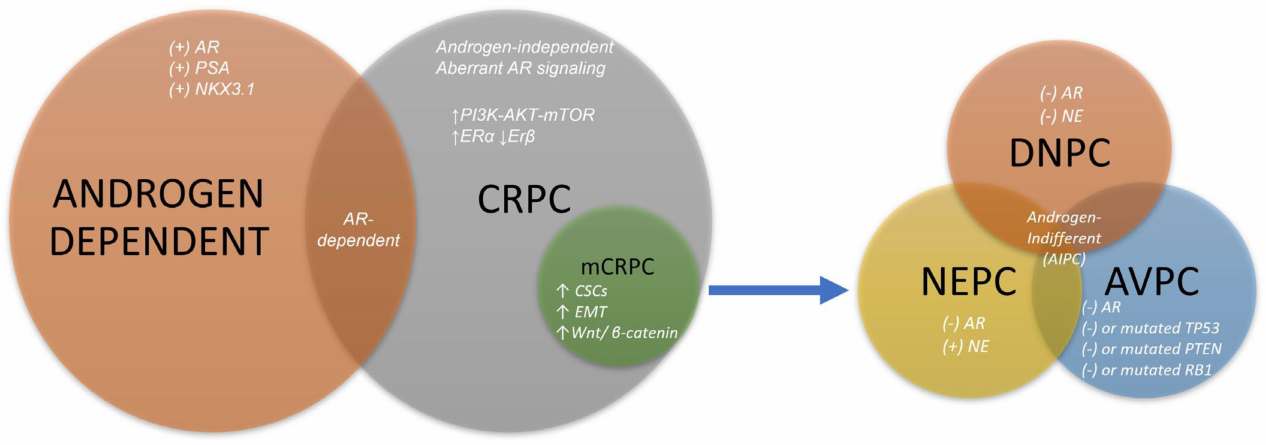
Figure 1. Molecular characteristics of each PCa variant or subtype. Prostate cancer is initially reliant on androgens binding to the AR and promoting growth. Genes commonly regulated and expressed secondary to this signaling include NKX3.1 and PSA. Castration-resistant is also reliant on aberrant AR signaling, which does not require androgen ligands. It also accumulates additional driver mutations in other genes and pathways, including PI3K-AKT-mTOR. A subtype of CRPC, mCRPC, is also known to acquire the overexpression of Wnt/B-catenin signaling, as well as increased CSCs and evidence of EMT. Lastly, AIPC is a group of PCas that are androgen-indifferent and usually AR-indifferent as well, and often arise from mCRPC. Subtypes of AIPC have specific molecular signatures. The DNPC has loss of AR- and NE-marker expression; AVPC has a loss of AR expression and mutation or loss in TP53 , PTEN , or RB1 ; and NEPC usually has loss of AR expression and gain in NE markers, such as chromogranin A or synaptophysin. Abbreviations: AR,